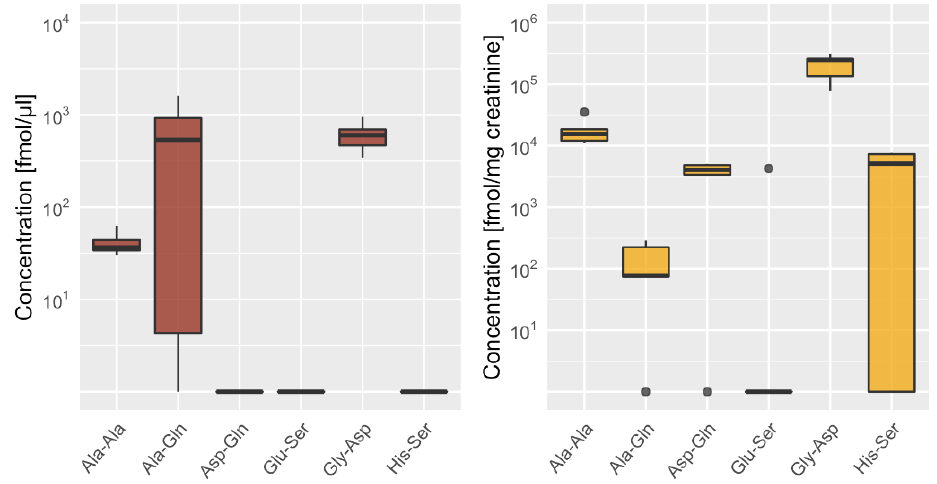
Figure 5. Distribution of the six most abundant dipeptides (except carnosine and anserine) in urine and serum. Box plot showing the distribution of Ala-Gln, Gly-Asp, Glu-Ser, His-Ser, Ala-Ala and Asp-Gln in urine in fmol/mg creatinine ( n = 5) and serum in fmol/ µ L ( n = 6), showing median as bold line with standard deviation and • indicating outliers.